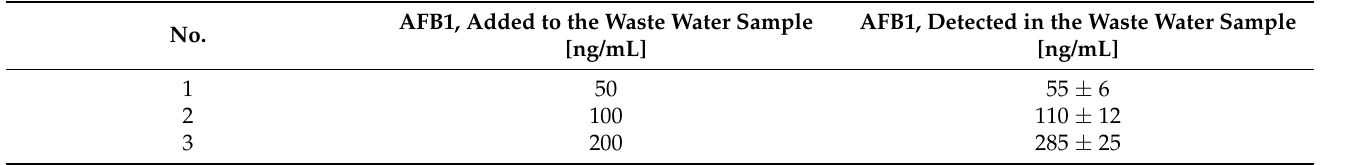
Table 6. Detection of aflatoxin B1 in waste water from a bread-making plant (Kiev, Ukraine) spiked with AFB1, n = 3, P = 0.95. Reproduced with permission from [93], ©